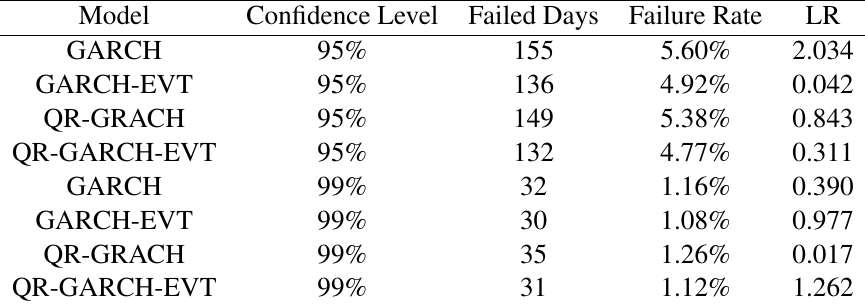
Table 4 Quantile Risk Value and Test Under Different